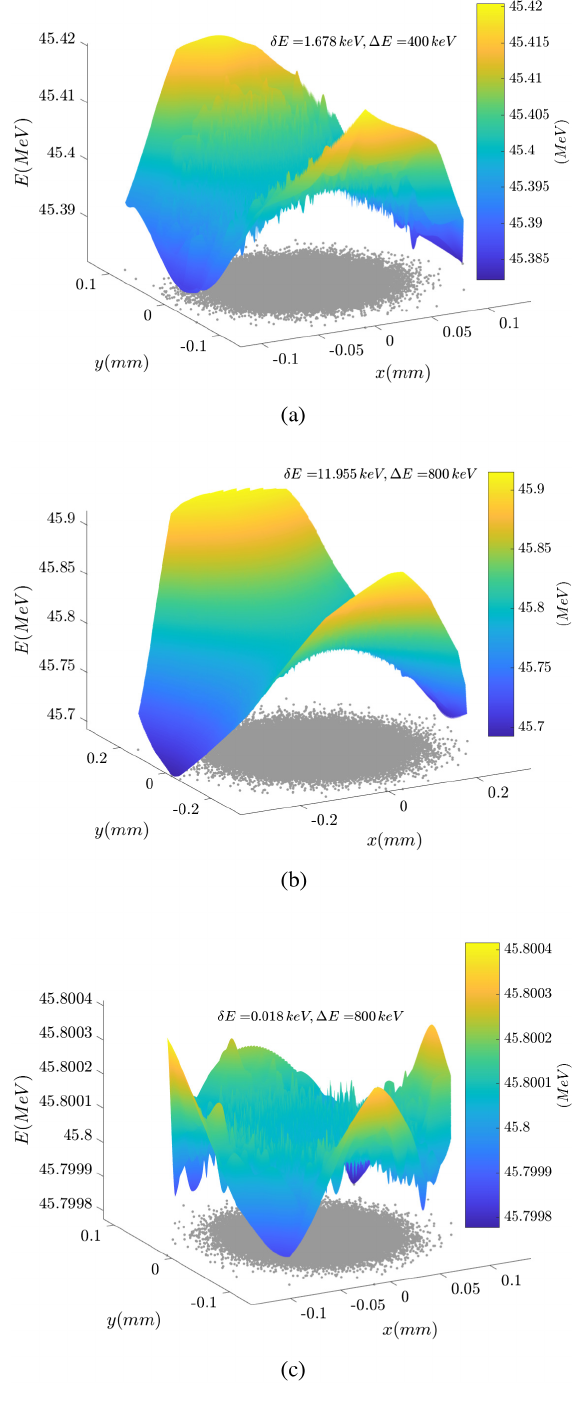
FIG. 7. Slice energy spread strongly correlated to the quadru- for an initially 45 MeV beam. (a) Propa- pole component of E Z gated through a single DLW, (b) two DLW stages separated with a 10 mm drift section without matching and (c) after the drift length is removed and matching algorithm employed. Results are for 400 keV energy gain per